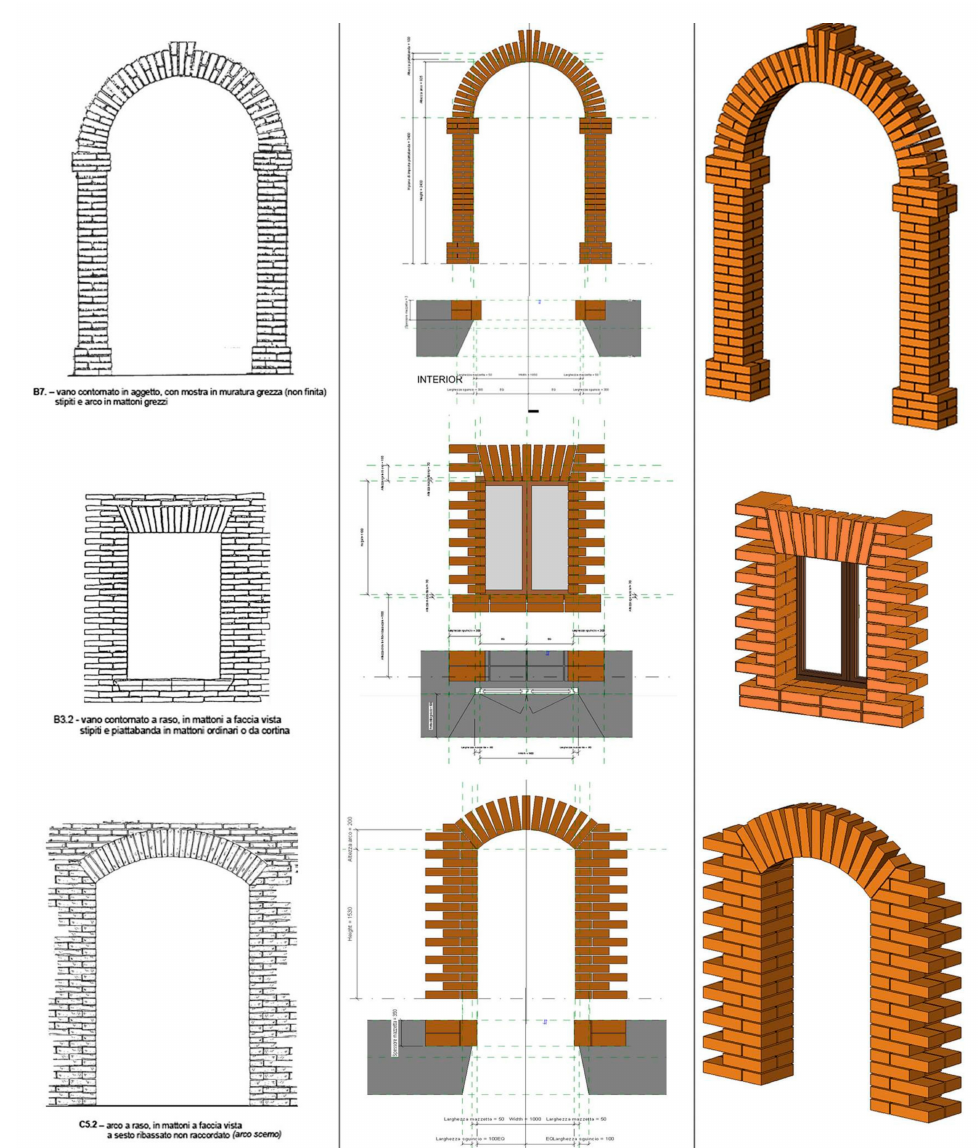
Figure 6. Comparison between the two-dimensional bibliographic reference, the medieval Umbrian manual repertory of the types, and recurring elements in a traditional building, and the three- dimensional parametric elements constructed based on typological recognition: ( a ) protruding compartment with unfinished masonry jambs (unfinished) and a rough brick arch, ( b ) compartment with a coplanar frame in exposed brick, with jambs and strips in the usual brick or for plugging, and a ( c ) coplanar arch in exposed brick with a lowered arch not